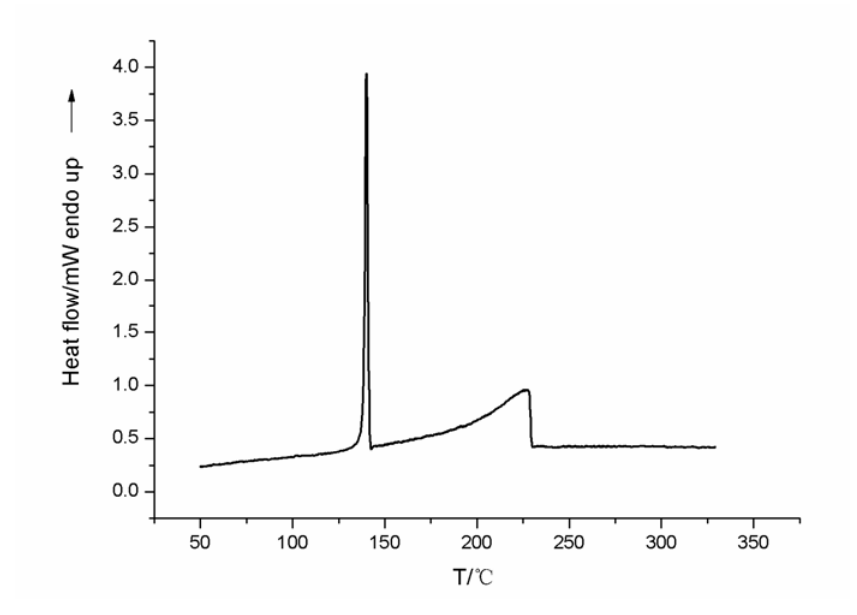
Figure 9. TG-DTG curve of